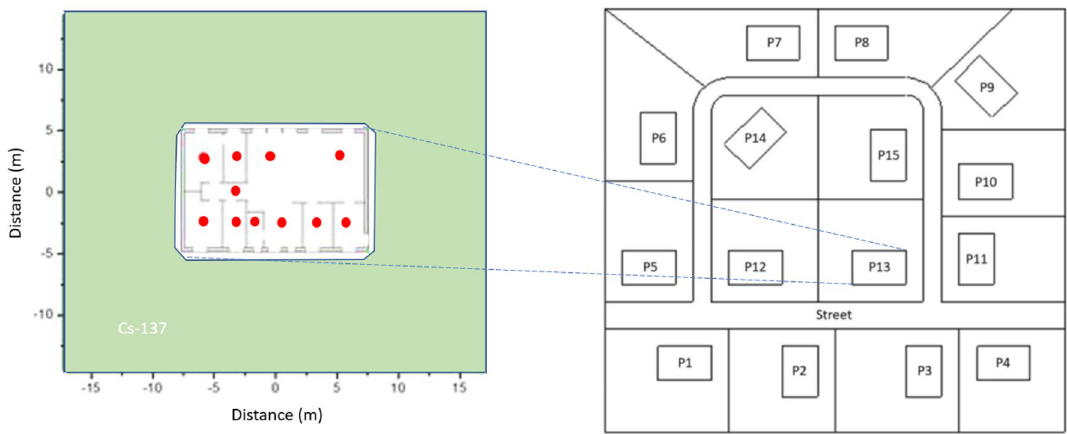
Figure 1. (Left) Schematic drawing of a modelled source geometry for a one-storey residential building (consisting either of brick or wood) surrounded by a rectangular deposition field of 137 Cs extended 10 m from the building walls. Red dots represent 11 different observation points used by 8 to compute air kerma rate. The average values of these air kerma rates are given in Table 1 and have been used in this study to derive the quantities relative damping factor, RDF in , and effective shielding factor, ESF . Details of the model can be found in 8 . (Right) Model of a suburban residential neighborhood as defined in 19 and further used in 20 . The model includes 15 replicates of the residential building defined in 8 .